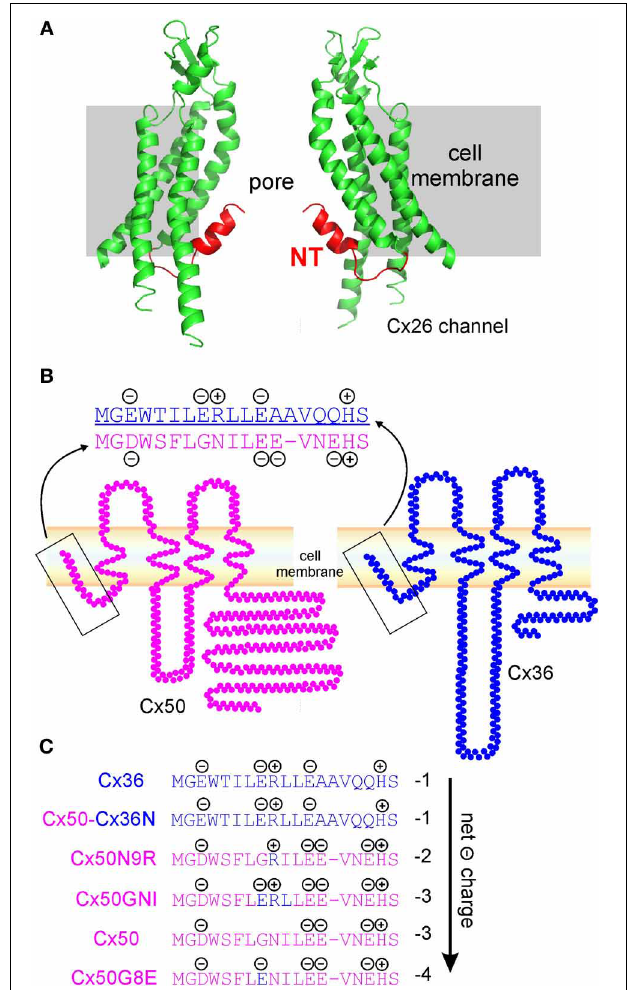
FIGURE 1 | Structure and topology models of Cx26, Cx50, and Cx36 gap junction channel. (A) Crystal structure model of Cx26 channel. Only two subunits of a hemichannel are displayed according to the resolved part of Cx26 channel (PDB 2ZW3, Maeda et al., 2009). Amino terminal domain (NT, red) of each subunit folds into the gap junction channel and lines part of the pore surface. (B) Topology models of Cx50 (pink) and Cx36 (blue) and the sequence alignment of amino terminal domain (NT). Four negatively charged residues, and one positively charged residue, are found at the terminal portion of Cx50 NT, and three negatively charged, and two positively charged residues exist on Cx36 NT. (C) Net charges of the NTs of Cx36, Cx50, and Cx50 mutants (Cx50Cx36N, Cx50N9R, Cx50GNI, and Cx50G8E) were calculated and ranked from low to high negativity (arrow). Blue text depicts residues of Cx36 NT and pink text indicates the residues from Cx50